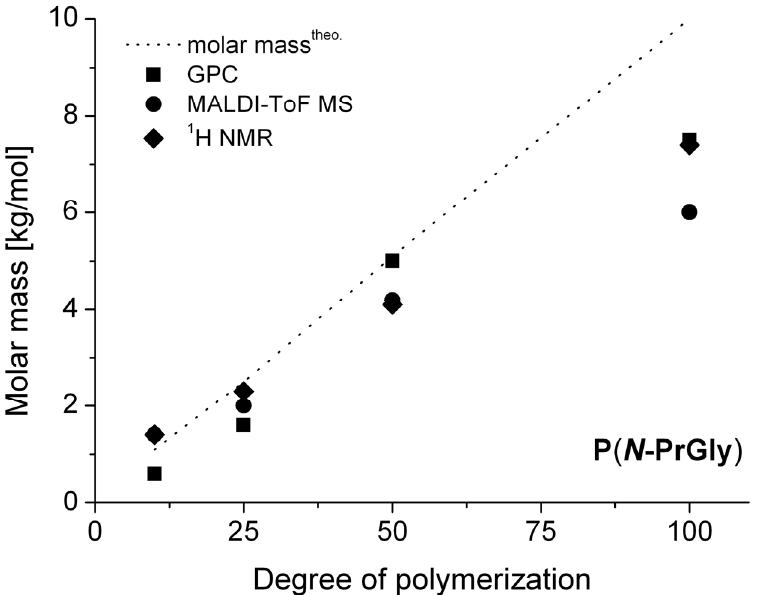
Figure 1. Correlation of the determined molar mass (by GPC, MALDI-ToF and 1 H NMR spectroscopy, respectively) of different poly( N -propylglycine) (P( N -PrGly)) with the theoretical molar mass.